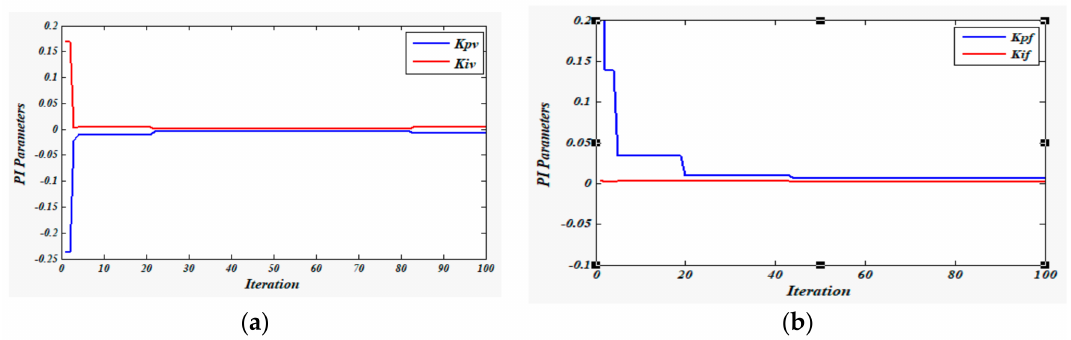
Figure 8. Optimal gain value searching process of WOA change of MG operating mode. ( a ) Gain values for voltage parameter; ( b ) Gain values for frequency